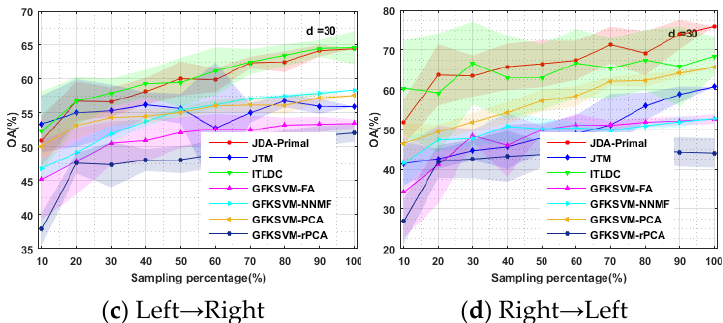
Figure 16. Classification accuracy curves for GFKSVM and other DA algorithms applied to ROSIS ( a , b ) and Houston ( c , d ) data. Each curve shows the average overall accuracy value with respect to the increasing size of training sets over 10 independent runs. The shaded areas show the standard deviation of the overall accuracy within the independent runs.